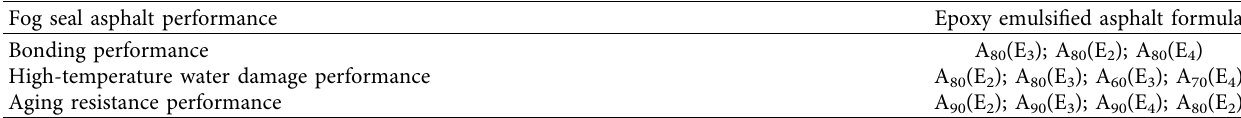
Table 10: Optimal formula for various